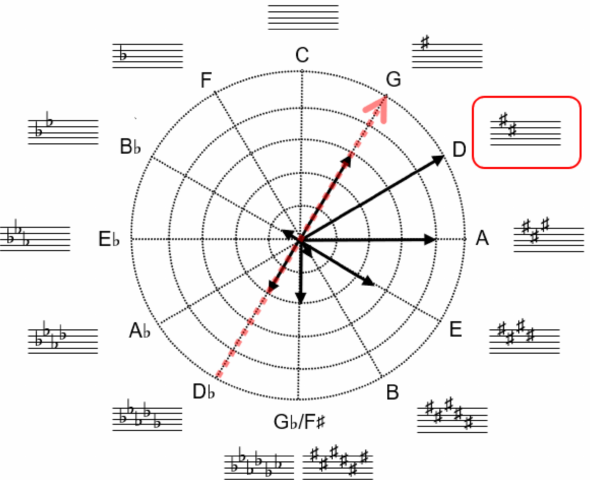
Figure 4. The main directed axis D (cid:91) → G and its corresponding key signature comprised of two sharps (2* (cid:93) ).